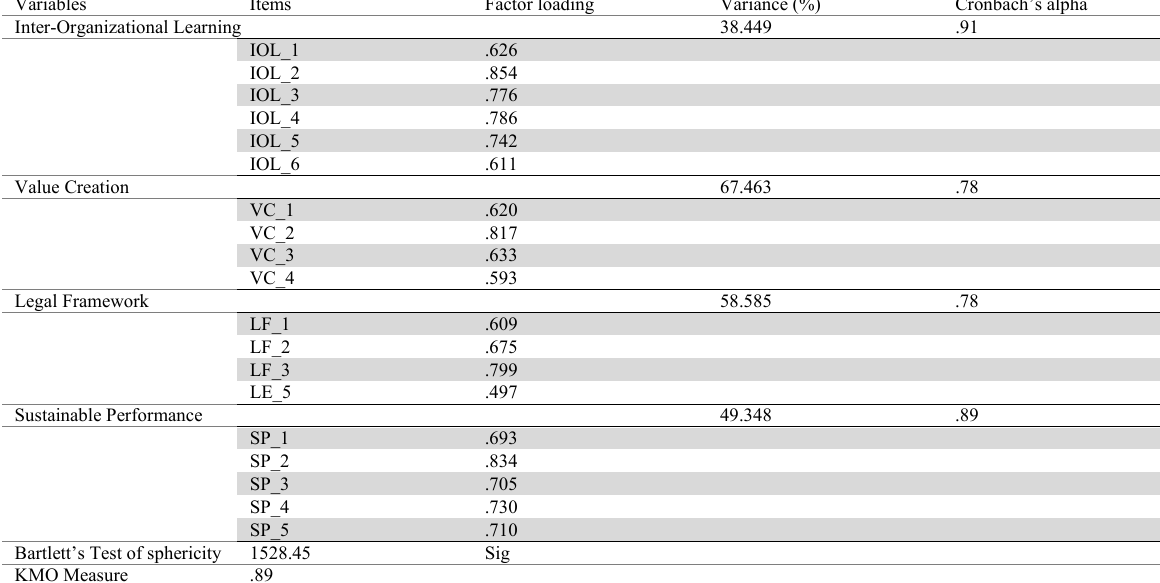
Factor analysis and reliability